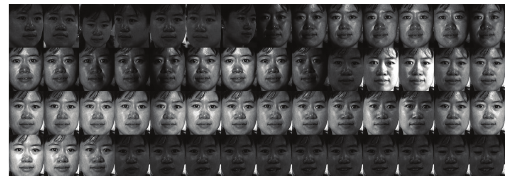
Figure 2: All images of one person from CMU-PIE database.